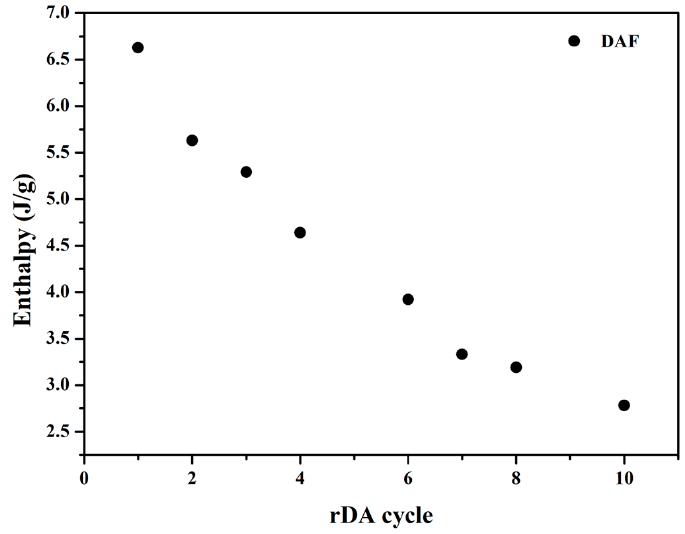
Figure 11. Variation in the enthalpy of the rDA reaction of solvent-free PUR adhesive containing DAF (PURSF-07, 9%TB) with the number of DA/rDA cycles.